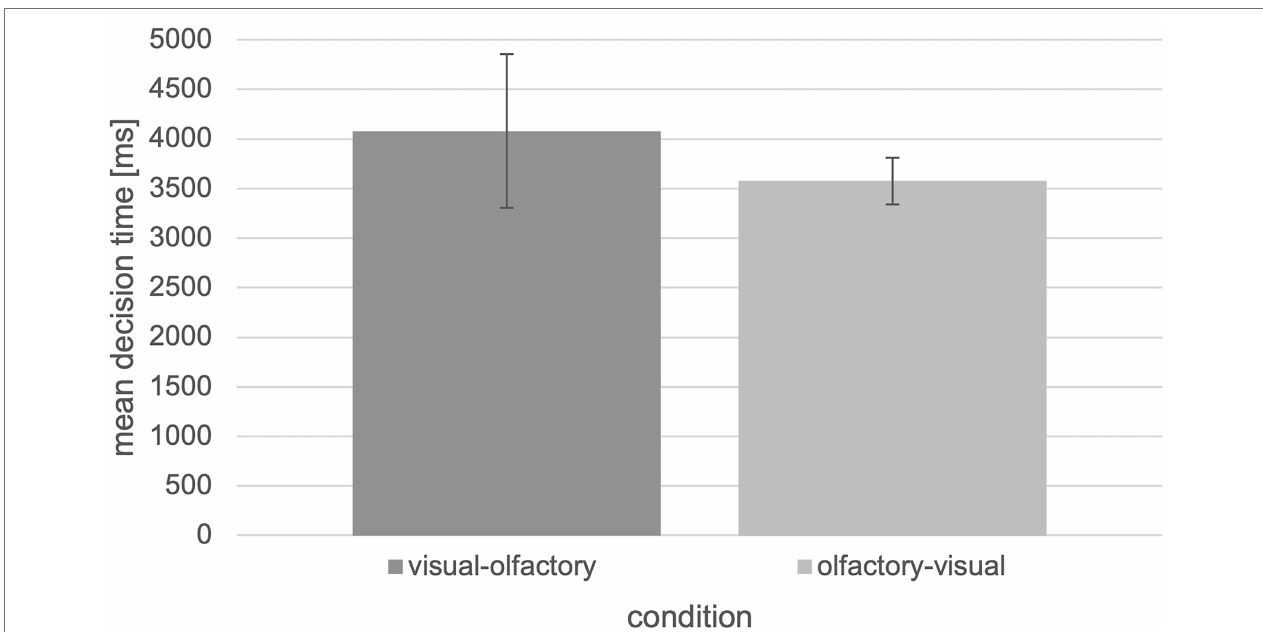
FIGURE 8 | Mean decision time in ms with respect to the “visual-olfactory” and “olfactory-visual” condition of the tested experiment ( N = 30, error bars = SEM in